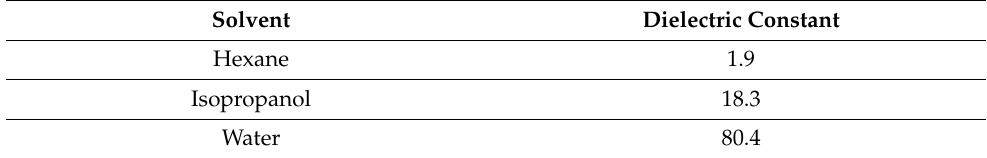
Table 1. Dielectric constant of some solvents